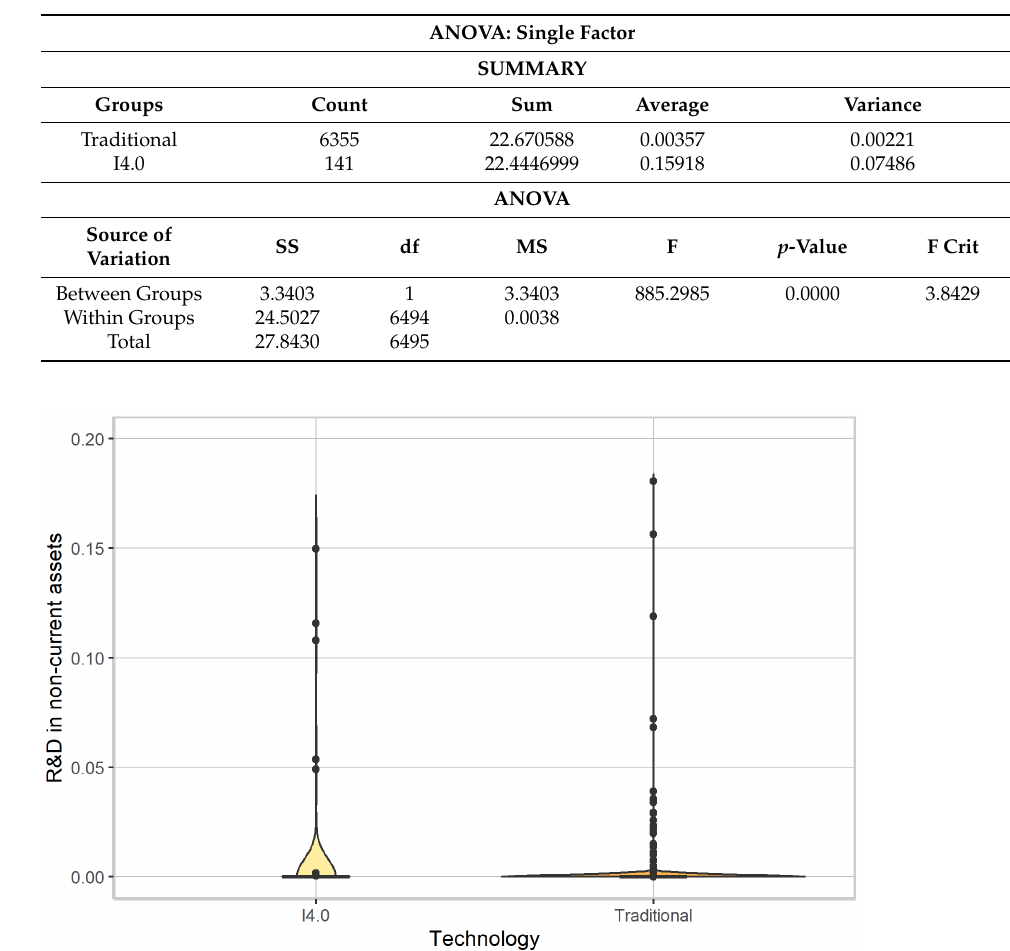
Table 8. ANOVA of the share of investment in research and development in long-term assets.